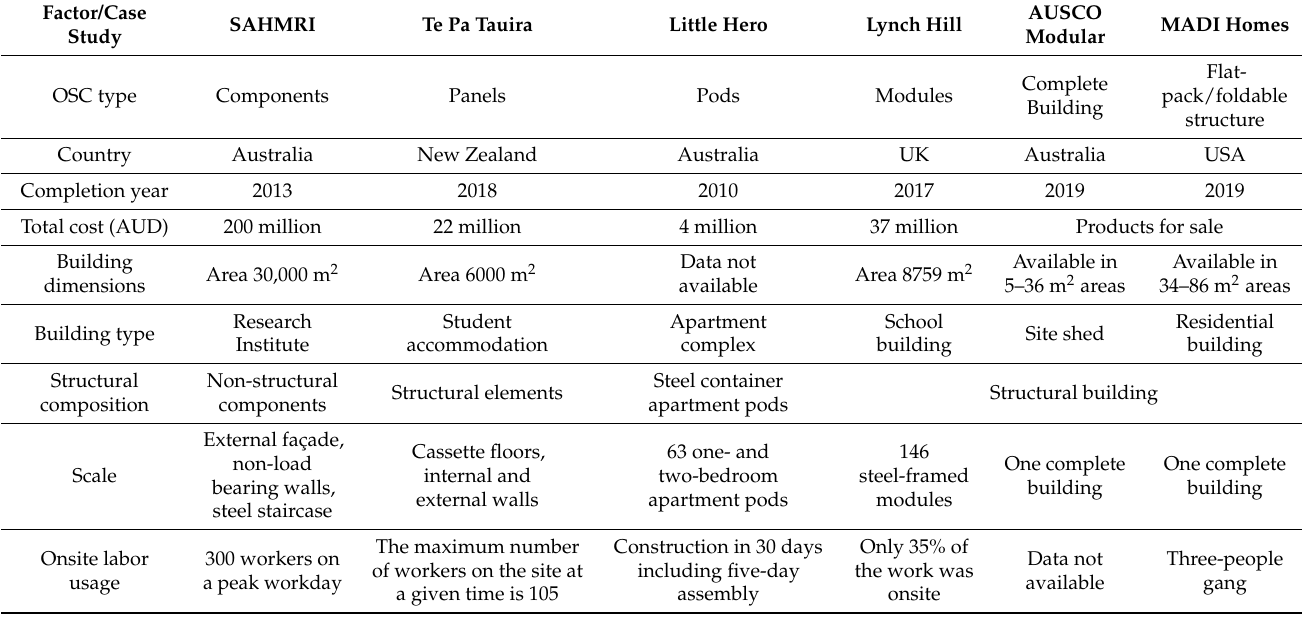
Table 2. Case study review using secondary